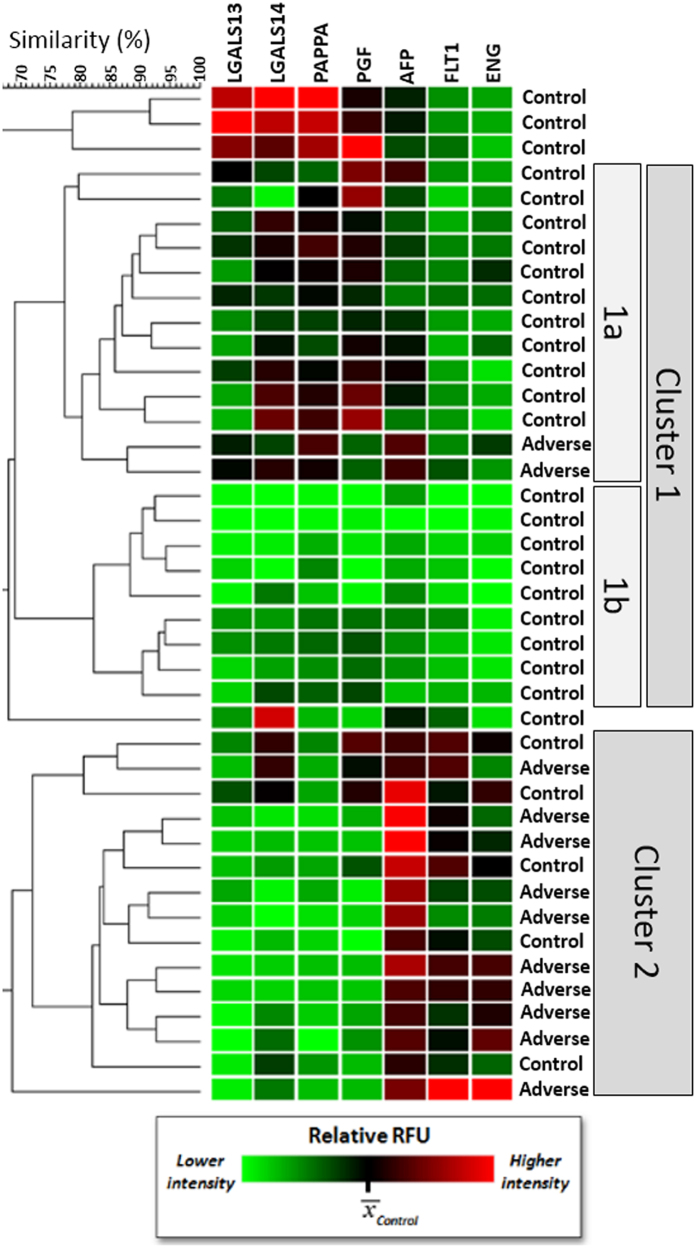
Hierarchical clustering analysis.Two major clusters were identified and are indicated as Cluster1 and Cluster2. Cluster1 was further subdivided into two sub-clusters (1a,1b) with distinguishable expression patterns. A third subgroup of three control pregnancies showing an “extreme” normal profile were clustered separately at the top of the chart, and have a high degree of similarity (78.8%).